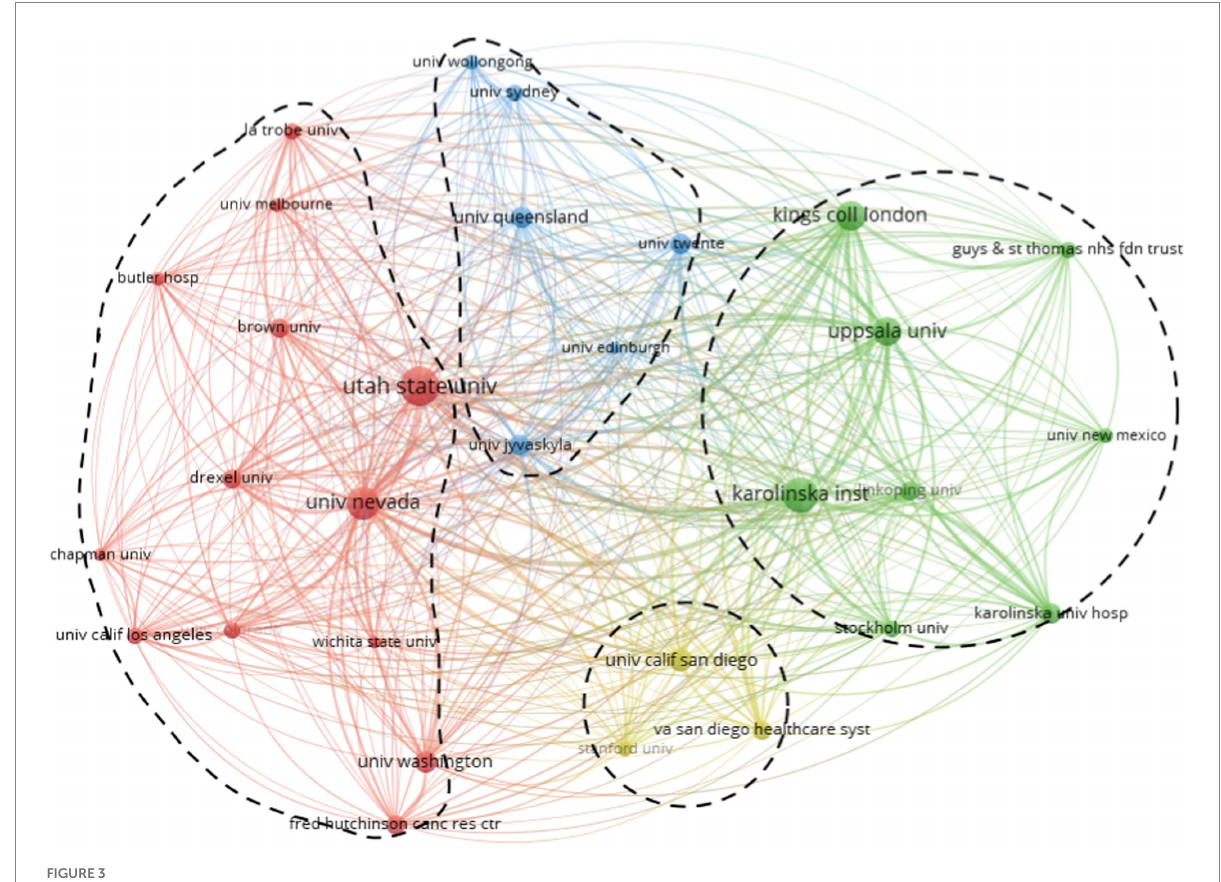
FIGURE 3 The network map of institutions from